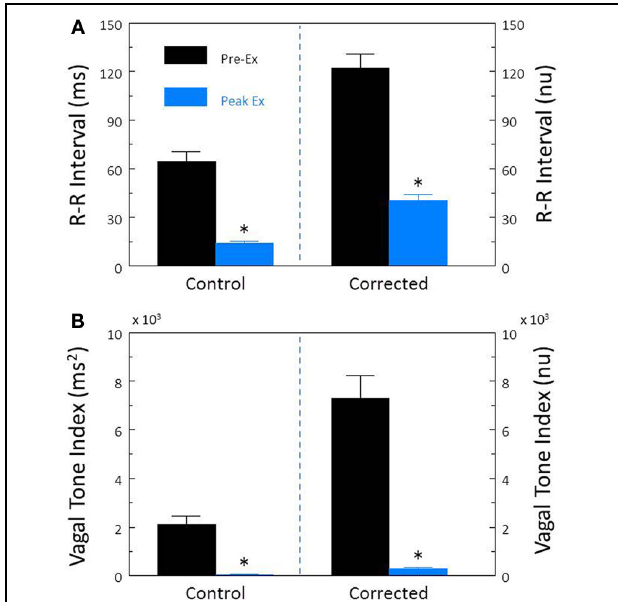
FIGURE 8 | The effect of activation of the baroreceptor reflex on heart rate variability. The α -adrenergic agonist phenylephrine HCl (10 μ g/kg, i.v; n = 20) was used to increase arterial blood 30–50mm Hg and thereby reflexively induce reductions in heart rate. The effects of this intervention on total heart rate variability (standard deviation of R-R interval, RRSD) without and with correction (RRSD/mean RRsec) are displayed in (A) . The effects of this treatment on the high frequency variability (cardiac vagal tone index, 0.24–1.04 Hz) without and with correction [cardiac vagal tone/(mean RRsec) 2 ] are shown in (B) . Note that both before and after correction for the phenylephrine-induced decreases in HR, baroreceptor reflex activation provoked significant increases in both RRSD and the cardiac vagal tone index. These data suggest that a reflexively mediated increase in cardiac parasympathetic activity is responsible for a large portion of the heart rate variability response to increases in arterial pressure independent of changes in HR. ∗ P < 0 . 01 pre (black bars) vs. post (blue bars); pre = last 30s before phenylephrine administration, post = 30s interval recorded 5min after this physiological intervention. nu, normalized units following HR